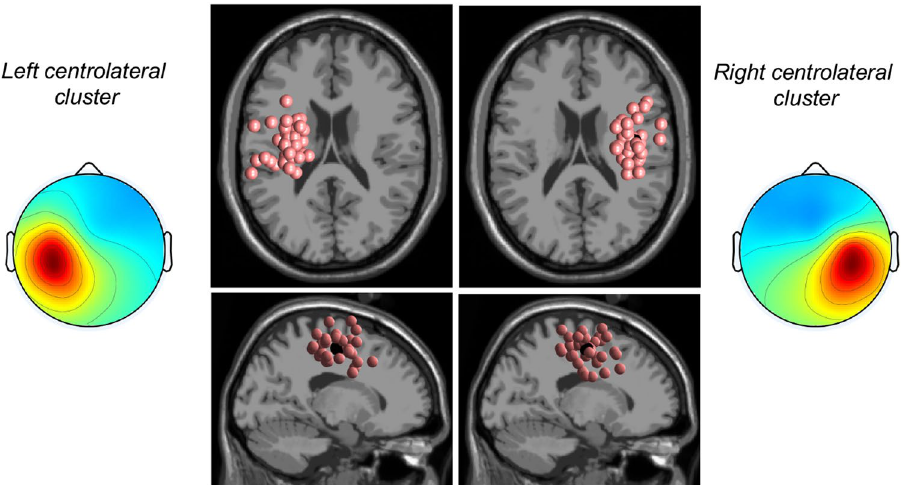
Figure 1. Middle columns: Equivalent dipole locations of the left and right centrolateral cluster ICs. Each individual IC is depicted by a smaller sphere (coral red) and the centroid of each cluster is represented by a larger sphere (black). Left and right: Scalp projections of each cluster